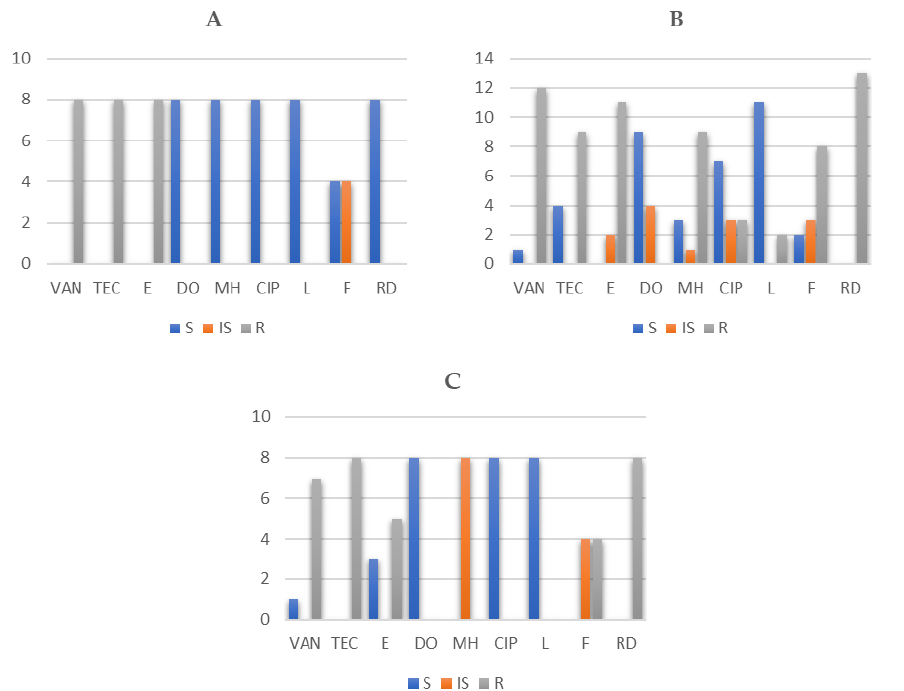
Figure 1. Number of resistant (R), intermediately resistant (IS), and susceptible (S) E. faecium ( n = 8) ( A ), E. faecalis ( n = 13) ( B ), and E. durans ( n = 8) ( C ) in goat cheese samples. n : number strains; VAN: vancomycin; TEC: teicoplanin; E: erythromycin; DO: doxycycline; MH: minocycline; CIP: ciprofloxacin; L: levofloxacin; F: nitrofurantoin; RD: rifampicin.